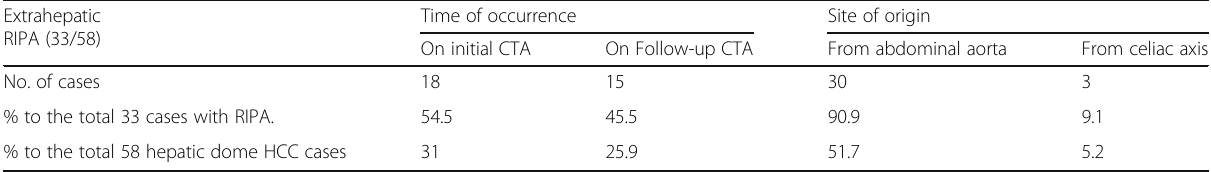
Extrahepatic RIPA (33/58)